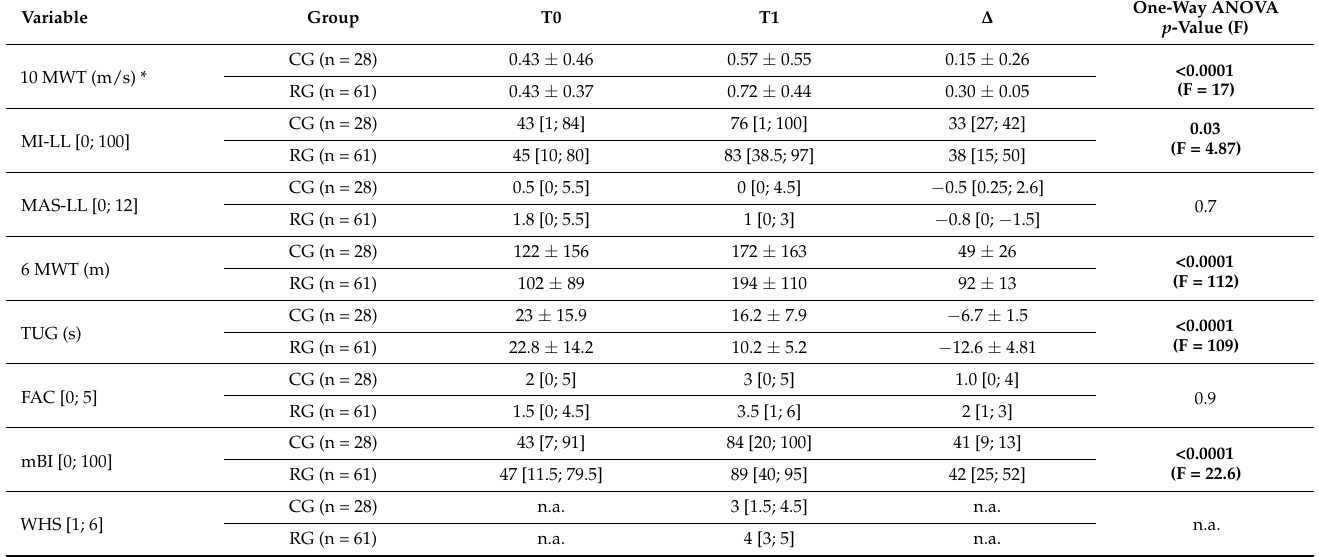
(Table 4). Better performance of the RobotEND-group than the RobotEXO-group was found in gait endurance, balance, and ADL, but these outcomes did not reach statistical significance. The other outcome measures showed no significant difference. A good level of independence in community ambulation was observed in all subjects at T1. Higher WHS values were observed in the RobotEND-group (4 [3; 5]) than in RobotEXO-group (3 [2; 5]). Table 3. Clinical outcomes of the Robotic Group (RG) and Control Group (CG) at baseline (T0) and final (T1) assessments. Changes ( ∆ = T1–T0) in functional outcomes and the corresponding one-way ANOVA values are depicted.